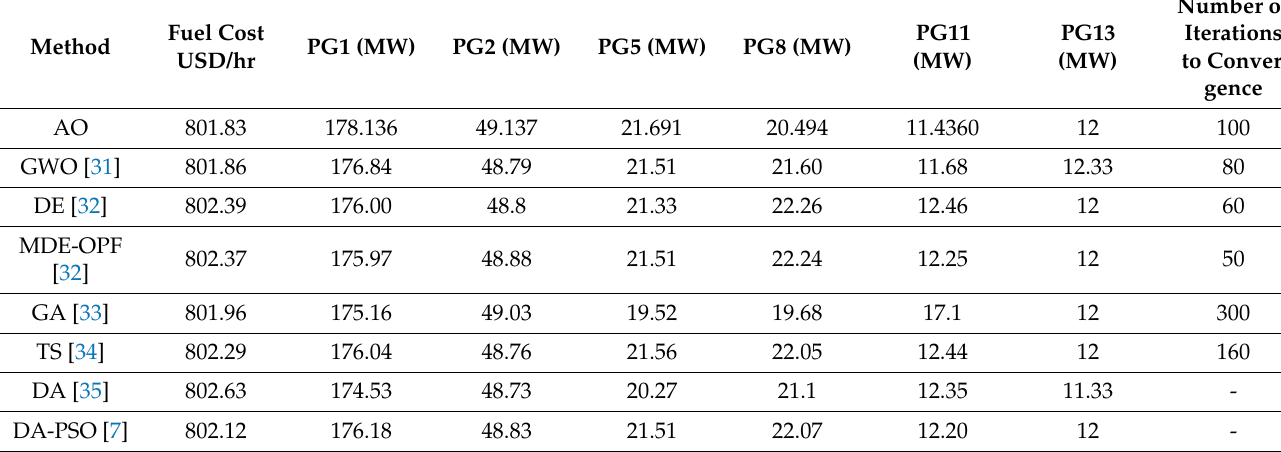
Figure 6. Fuel cost comparison for IEEE-30 bus system. Table 2. Result comparison for OPF IEEE ‐ 30 bus system